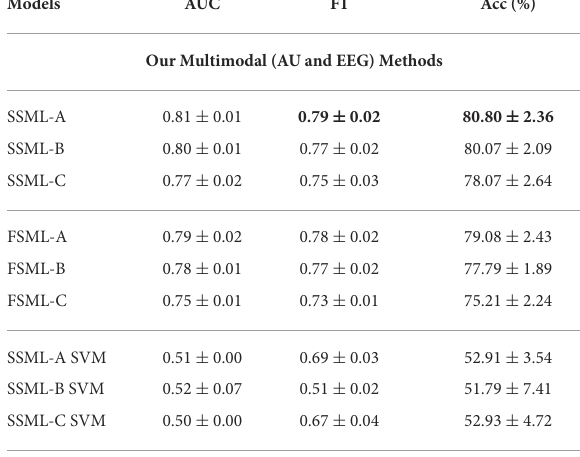
TABLE 2 Multimodal downstream task performance statistics. Here, SSML-* describes the results with pre-trained H AU and H EEG following SSML-* architecture with 3 additional dense layers for the downstream